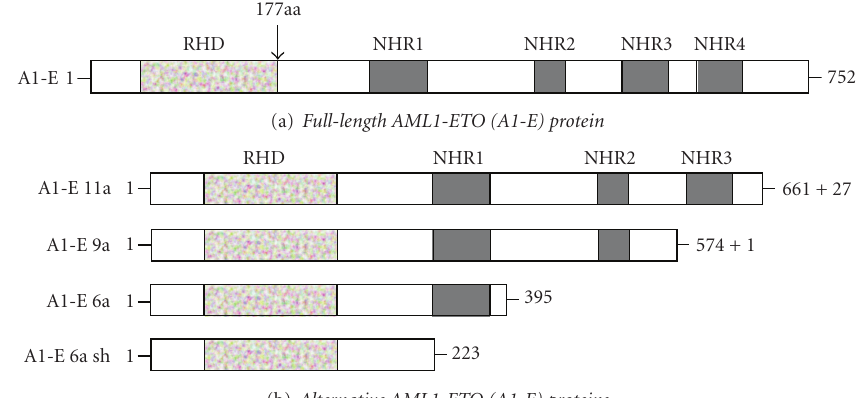
Figure 1: Domain organizationof the full-length and alternative AML1-ETO fusion proteins. (a) The full-length AML1-ETO (A1-E) protein is shown, where most of the ETO (RUNX1T1) gene is fused into the N-terminal 177aa of AML1 (RUNX1) gene giving rise to a transcript coding for a protein of 752 amino acids (aa). The AML1 gene encodes the Runt homology domain (RHD) which is a DNA-binding protein, while ETO encodes four highly conserved functional domains called nervy homology domains (NHR1-4). (b) Di ff erent fusion transcripts arise due to alternative exon usage and splicing, which give rise to truncated proteins lacking NHR domains. Protein size (i.e., number of aa) is shown on the right with the number of additional aa that were not included in the original sequence. These alternative A1-E transcripts can be coexpressed alongside the full-length transcript and have di ff erent leukemogenic capabilities.